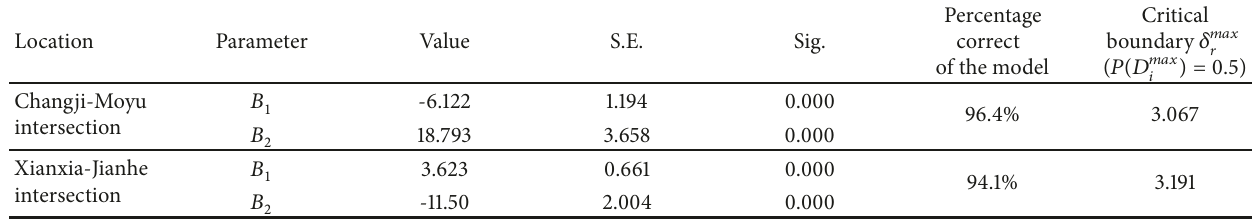
Table 1: Parameters of the binary logistic model at two